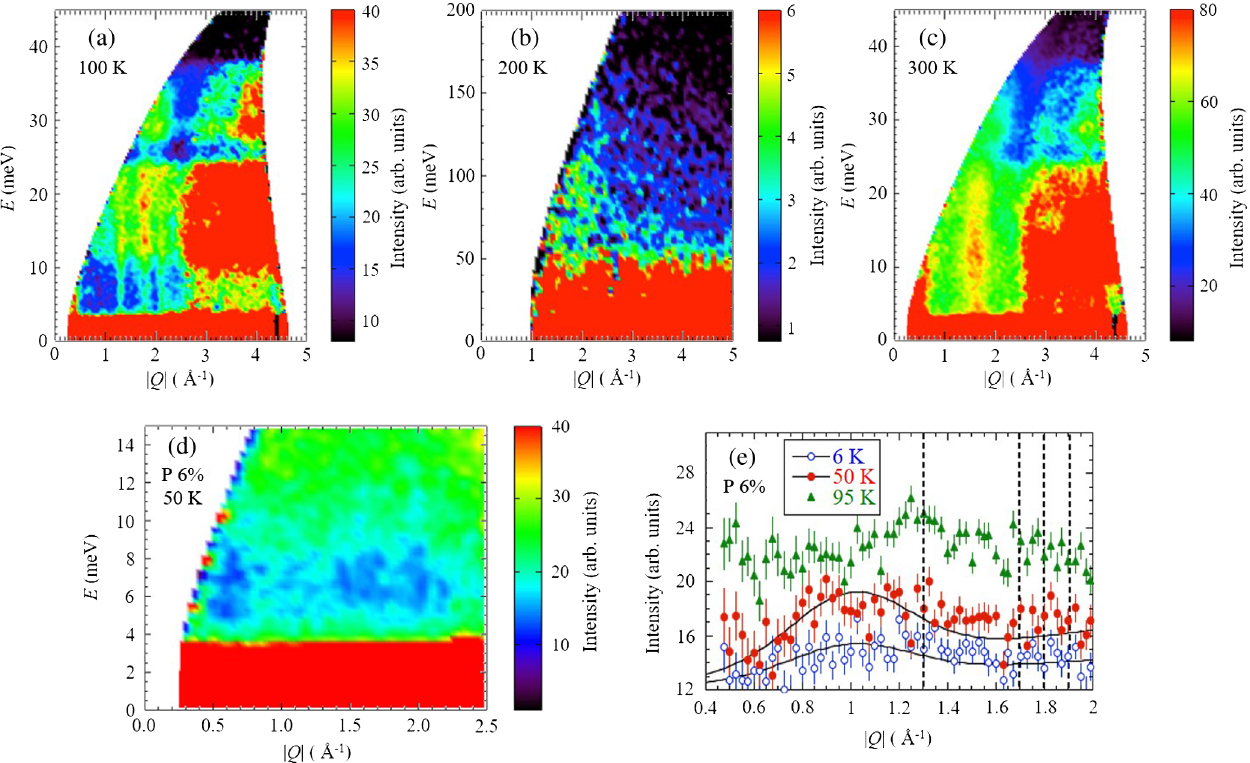
clarity.FIG. 3. Color contour maps of the INS intensity S ðj Q j ; E Þ for polycrystalline CrAs measured at (a) T ¼ 100 K and (c) 300 K with ¼ 50 meV and at (b) T ¼ 200 K with E ¼ 800 meV. Background scattering measured with an empty sample can is subtracted. E i i ¼ 50 meV at T ¼ 50 K. The intensity scales of the two samples are (d) S ðj Q j ; E Þ for polycrystalline CrAs 0 P 0 measured with E i . 94 . 06 normalized using incoherent scattering. (e) S ðj Q jÞ integrated with respect to energy between 4.0 and 7.5 meVat T ¼ 6 , 50, and 95 K for CrAs 0 P 0 . The solid lines are guides to the eye. The broken lines represent the positions where spin-wave excitations from the . 94 . 06 magnetically ordered phase are